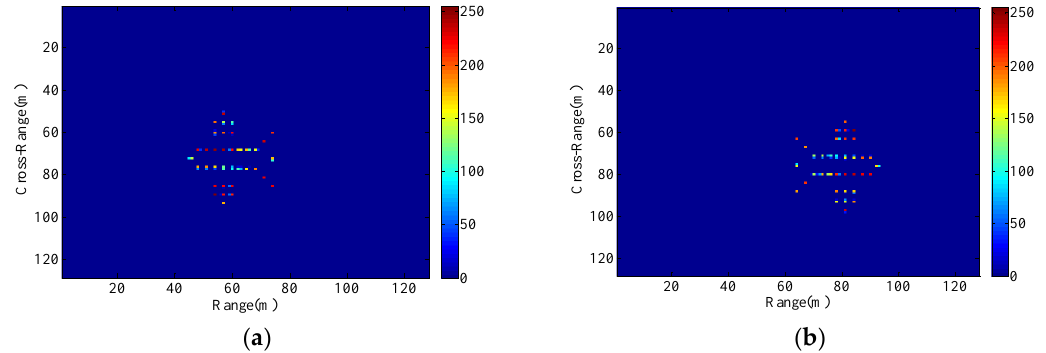
Figure 14. Imaging results with the radar platform displacement parameters P8. ( a ) P9; ( b ) P10.